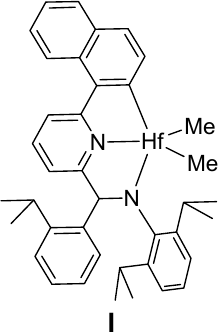
Figure 1. A flagship catalyst in the post-metallocenes.